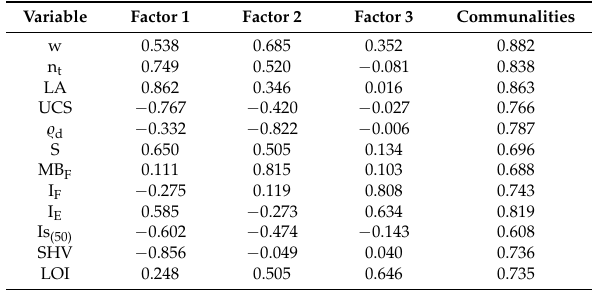
Table 4. R-mode factor analysis: Loadings for the varimax rotated 3-factor